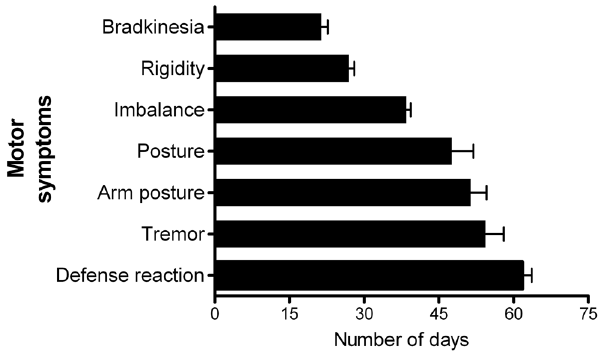
Figure 1. Evolution of daily motor scores for each monkey (group I and II) under MPTP induction. The animals received progressive MPTP injection (0.2 to 0.4 mg/kg, i.m.) every 2 to 3 days until motor symptoms were fully expressed ( a total Kurlan score . 15).